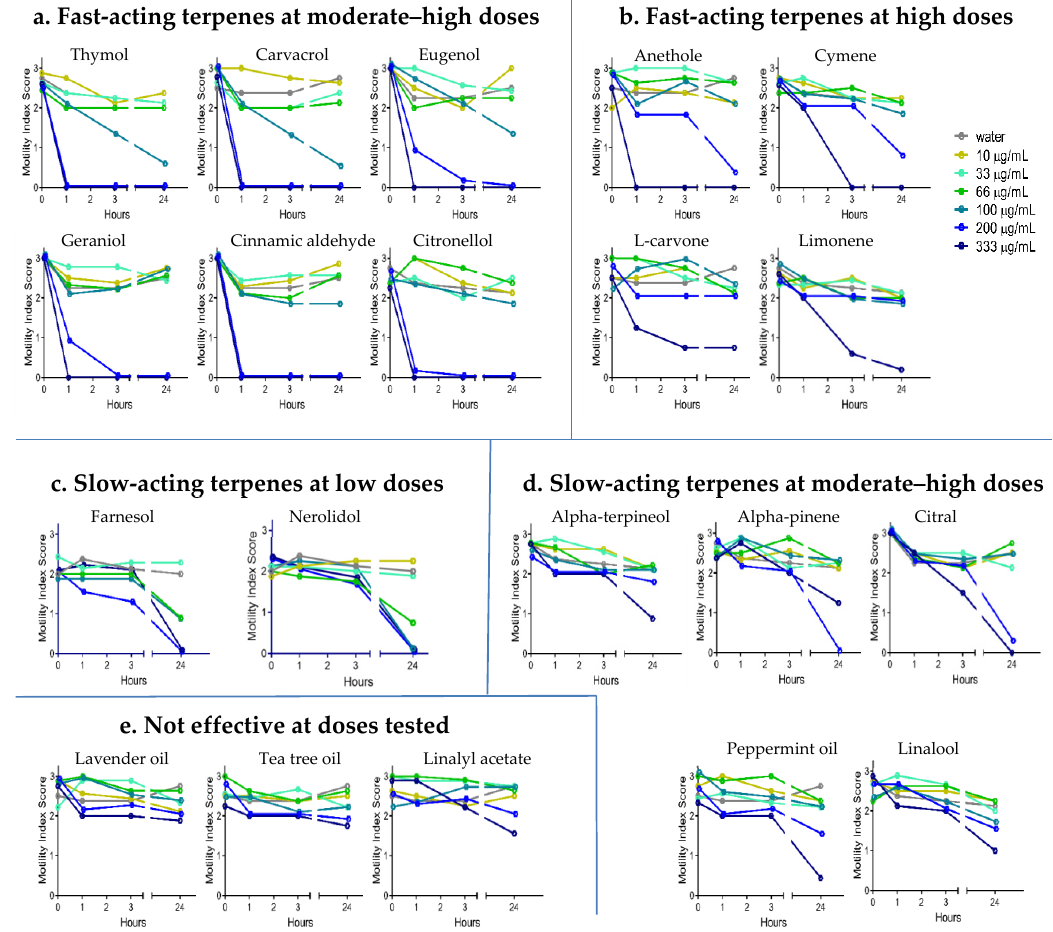
Figure 2. Dose–response of YP–terpenes on adult Ancylostoma ceylanicum in vitro, as shown for ( a ) fast-acting terpenes at moderate–high doses, ( b ) fast-acting terpenes at high doses, ( c ) slow-acting terpenes at lower doses, ( d ) slow-acting terpenes at moderate–high doses, and ( e ) terpenes not effective at the doses tested. Terpenes were evaluated at concentrations from 0 to 333 µg/mL. Parasitic worms were scored at the times indicated for motility, where 3 is actively moving, 2 is slow moving, 1 is not moving unless touched, and 0 is not moving even when touched (likely dead). N = eight adult worms/condition.